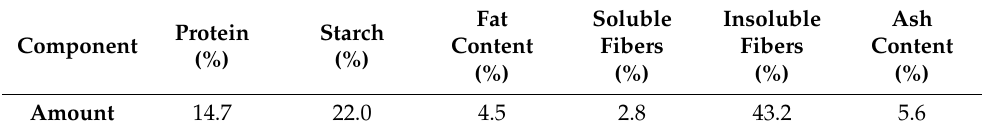
Table 4. Composition of the barley bran used, as provided by the feed supplier.